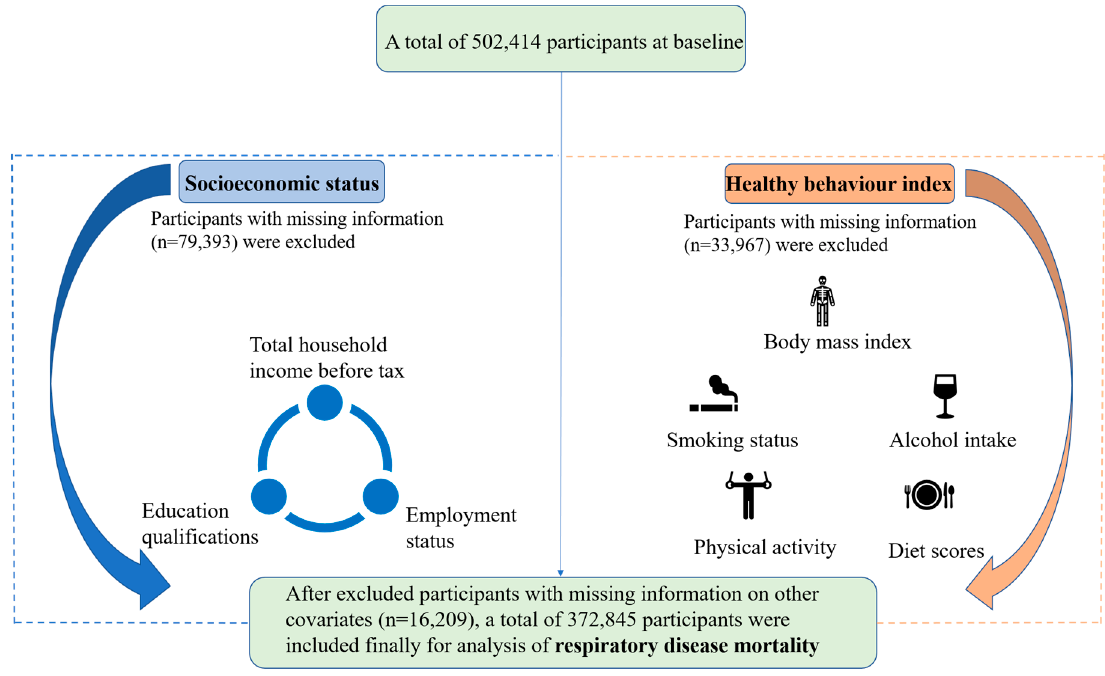
Figure 1. The study fl owchart.